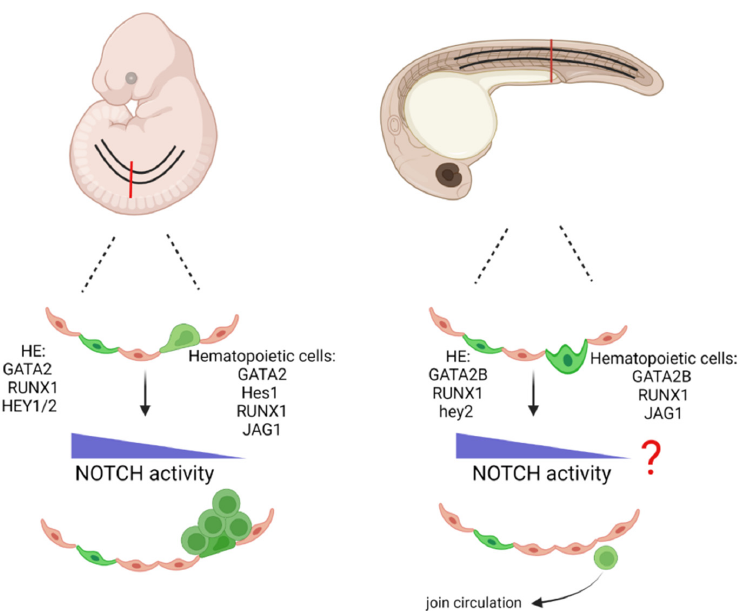
Figure 4. A comparison of zebrafish and mouse embryonic aortic hematopoiesis. Depicted are Notch signaling molecules that act during hemogenic endothelium specification and intra-aortic cluster formation. In mouse EHT, the hematopoietic cells accumulate as clusters and have low(er) Notch activity (left). During zebrafish hematopoiesis, cells undergoing EHT leave the aorta individually and do not accumulate as clusters. Green: cells with hematopoietic properties. HE: hemogenic endothelium. Created with BioRender.com (accessed on 15 January 2022). Finally, plasticity of ES-derived hemogenic cells may be totally different from the embryonic precursors. One of the studies separated arterial endothelium from HSPC competent HE by using cell surface markers CD73 − CD184 − during hES differentiation to blood. When Day 8 Embryoid Bodies are separated based on CD34, CD73 and CD184, they find that arterial cells expressing EfnB2 are highly enriched in the CD73medCD184+ cells, but EHT competent HE cells are found in the CD34 + CD73 − CD184 − DLL4 − cell com- partment based on hematopoietic marker [137].